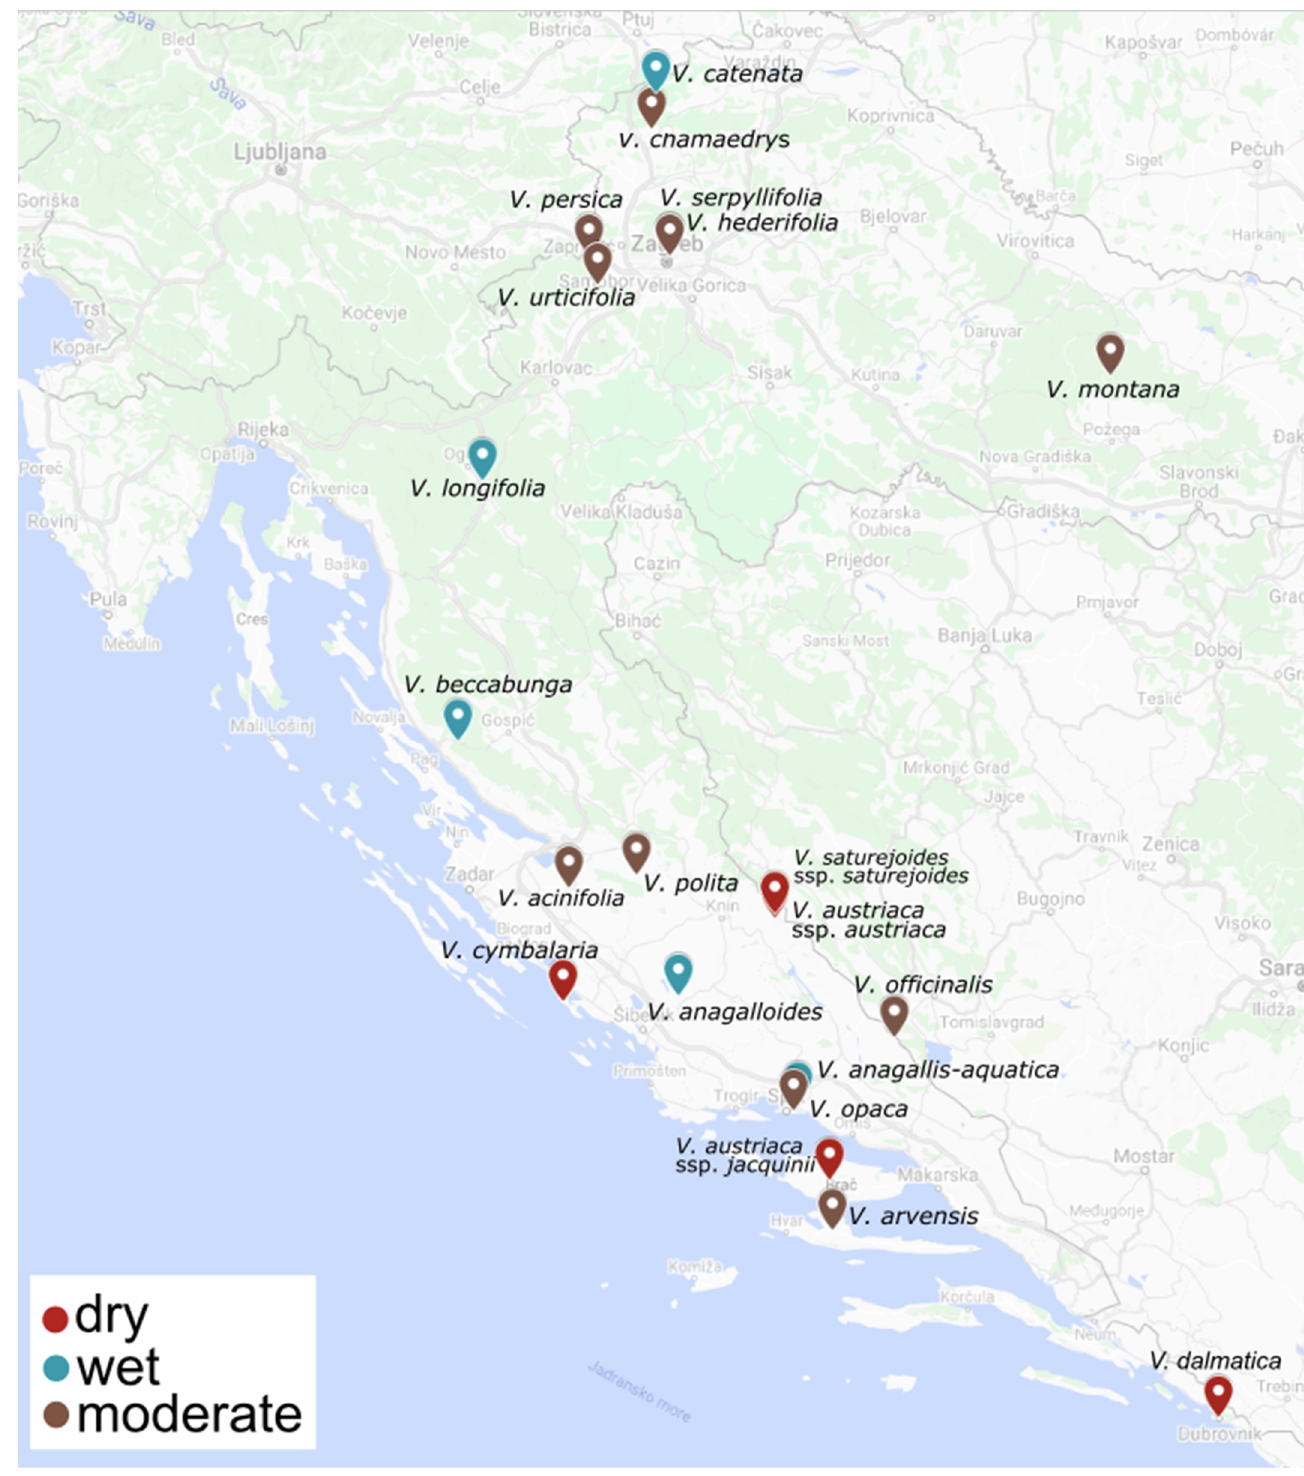
Figure 9. Map of the sites at which the studied Veronica taxa were collected. Table 1. Details of the data collection and origin of the investigated Veronica taxa. Dried aboveground parts of the plant leaves, stems, and flowers (30–50 g) for each plant species were subjected to two different extraction methods: hydrodistillation and microwave-assisted extraction. The extracts, which were collected in pentane and diethyl ether (VWR, Radnor, PA, USA) from both extraction methods for all plant species, were dried over anhydrous sodium sulphate and stored at − 20 ◦ C until